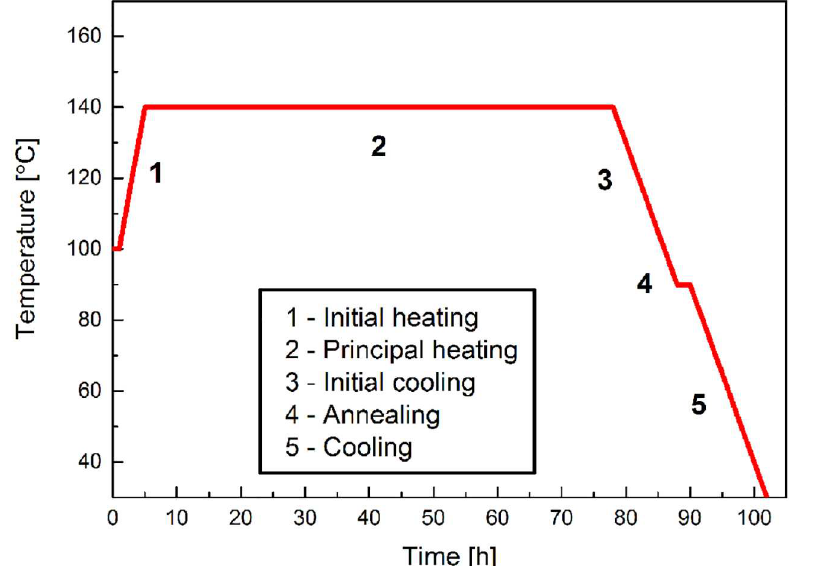
Fig 3. Thermal schedule for scintillator